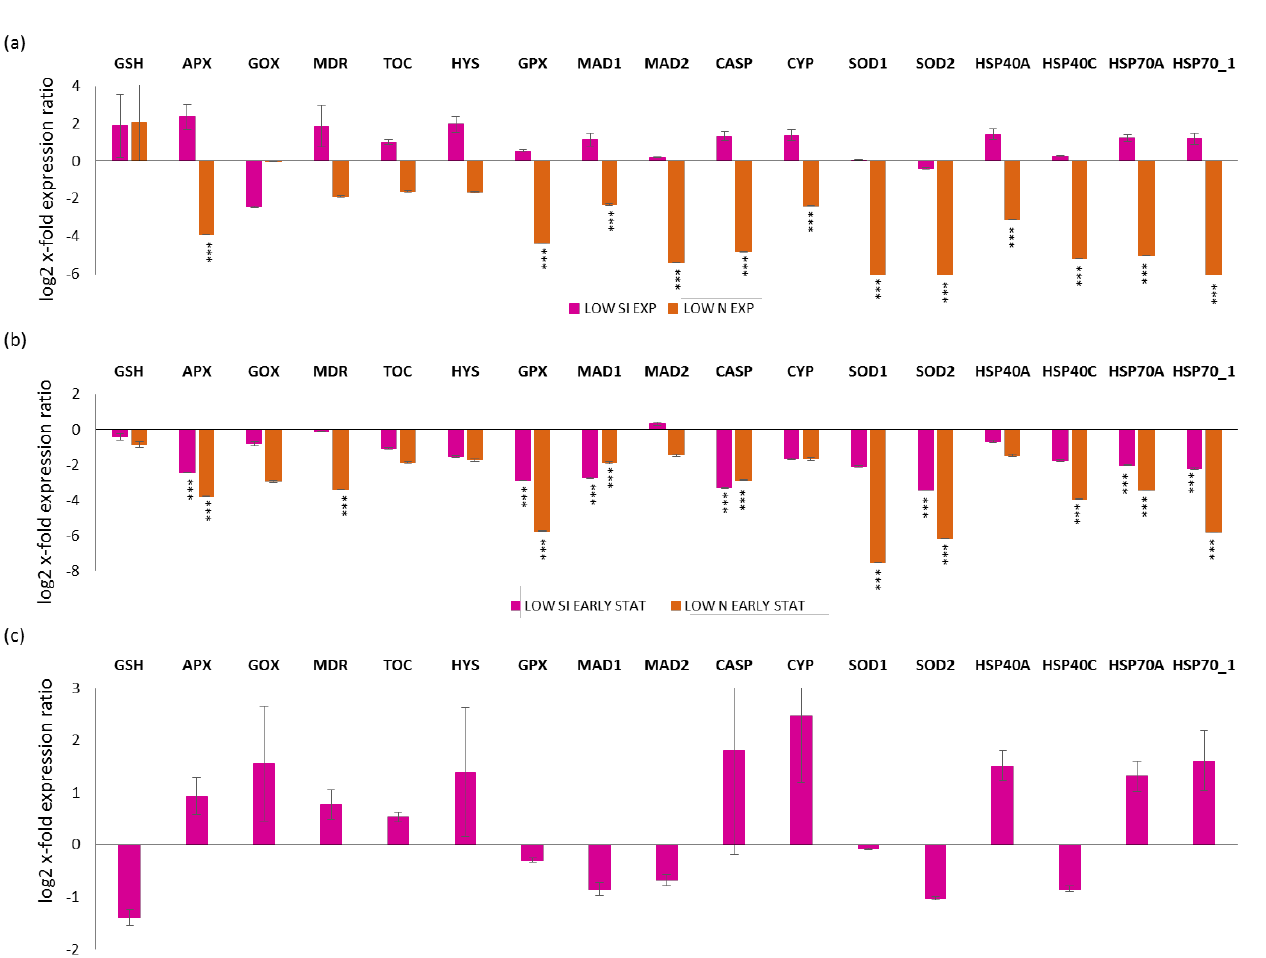
Figure 3. Expression levels of selected stress responsive genes in P. tricornutum cells in ( a ) LOW SI and LOW N exponential phase compared to the control condition (Replete condition exponential phase; x-axis); ( b ) LOW SI and LOW N early stationery phase compared to the control condition (Replete condition early stationery phase); ( c ) LOW SI late stationery phase compared to the control condition (Replete condition late stationery phase). Data are represented as log2 x-fold expression ratio ± SD (n = 4; *** p < 0.001, Student’s t -test). Abbreviations stands for glutathione synthase (GSH), ascorbate peroxidase (APX), glycolate oxidase (GOX), multidrug resistance protein (MDR), tocopherol cyclase (TOC), hystone deacetylase (HYS), glutathione peroxidase (GPX), mitotic spin- dle assembly checkpoint proteins (MAD1 and MAD2), metacaspase (CASP), cytochrome P450 (CYP450), superoxide dismutase 1 and 2 (SOD1 and SOD2, respectively) and heat shock proteins 40A, 40C, 70.1, and 70A (HSP40A, HSP40C, HSP70_1, HSP70A). 2.4. Expression Levels of Stress-Responsive Genes along the Growth Curve Gene expression analyses were also performed for each studied condition (i.e., re- plete, LOW SI, and LOW N during the growth curve) by comparing early stationery and late stationery (except for LOW N) versus the exponential phase (x-axis; Figure 4). Re- garding the replete condition (Figure 4a), there was the up-regulation of the antioxidant enzyme GSH in both early and late stationery phase ( p < 0.001 for both conditions), while the down-regulation of HSP70_1 in the early stationery phase and APX, CASP, HSP70A and HSP70_1 in the late stationery phase ( p < 0.001 for all; Figure 4a). In the LOW SI condition (Figure 4b), there was the down-regulation of CYP and SOD2 only in the early stationery phase, while there was down-regulation of APX, CASP, HSP70A, and HSP70_1 both in the early and late stationery phase ( p < 0.001 for all). Regarding the LOW N condition (Figure 4c), there was down-regulation only in the case of GOX ( p < 0.001).